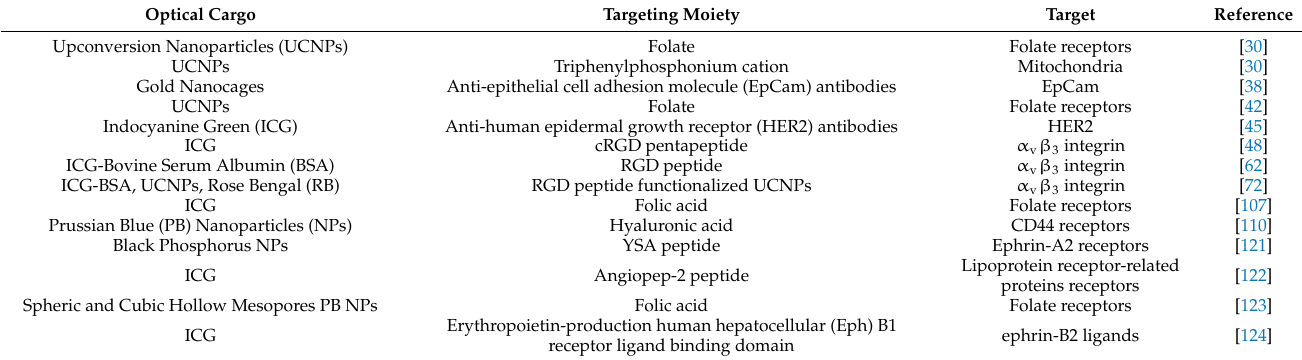
Table 2. Examples of optical RBC-derived constructs functionalized using DPSE lipid insertion. Optical